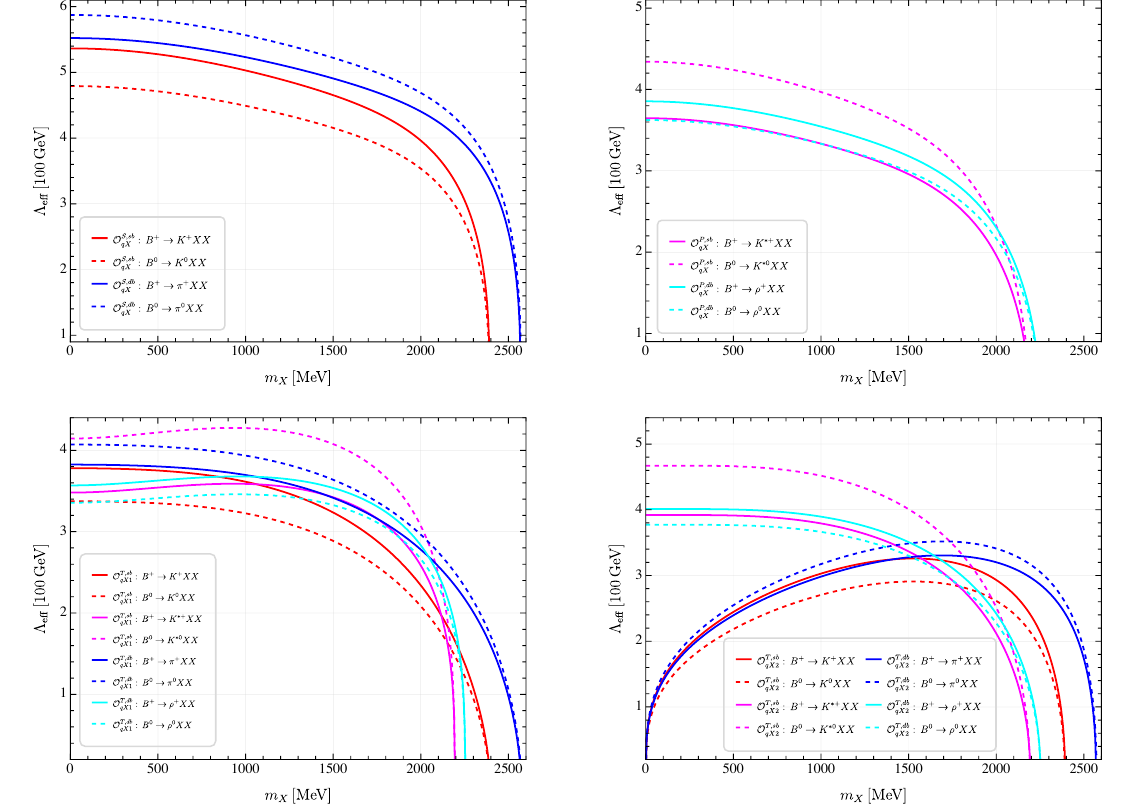
Figure 4 . Constraints on the effective new physics scale for the 4 dim-5 operators O S,P as a function of the DM mass m from B → K ( π ) /E